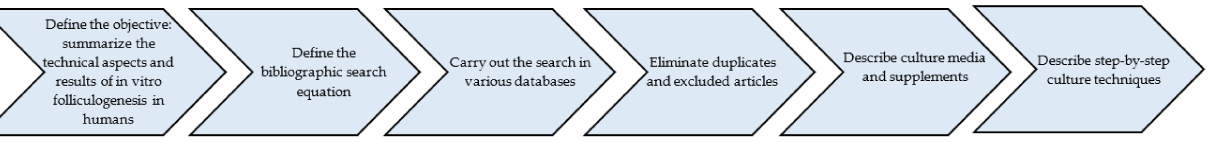
Figure 2. Summary of the steps used to build the